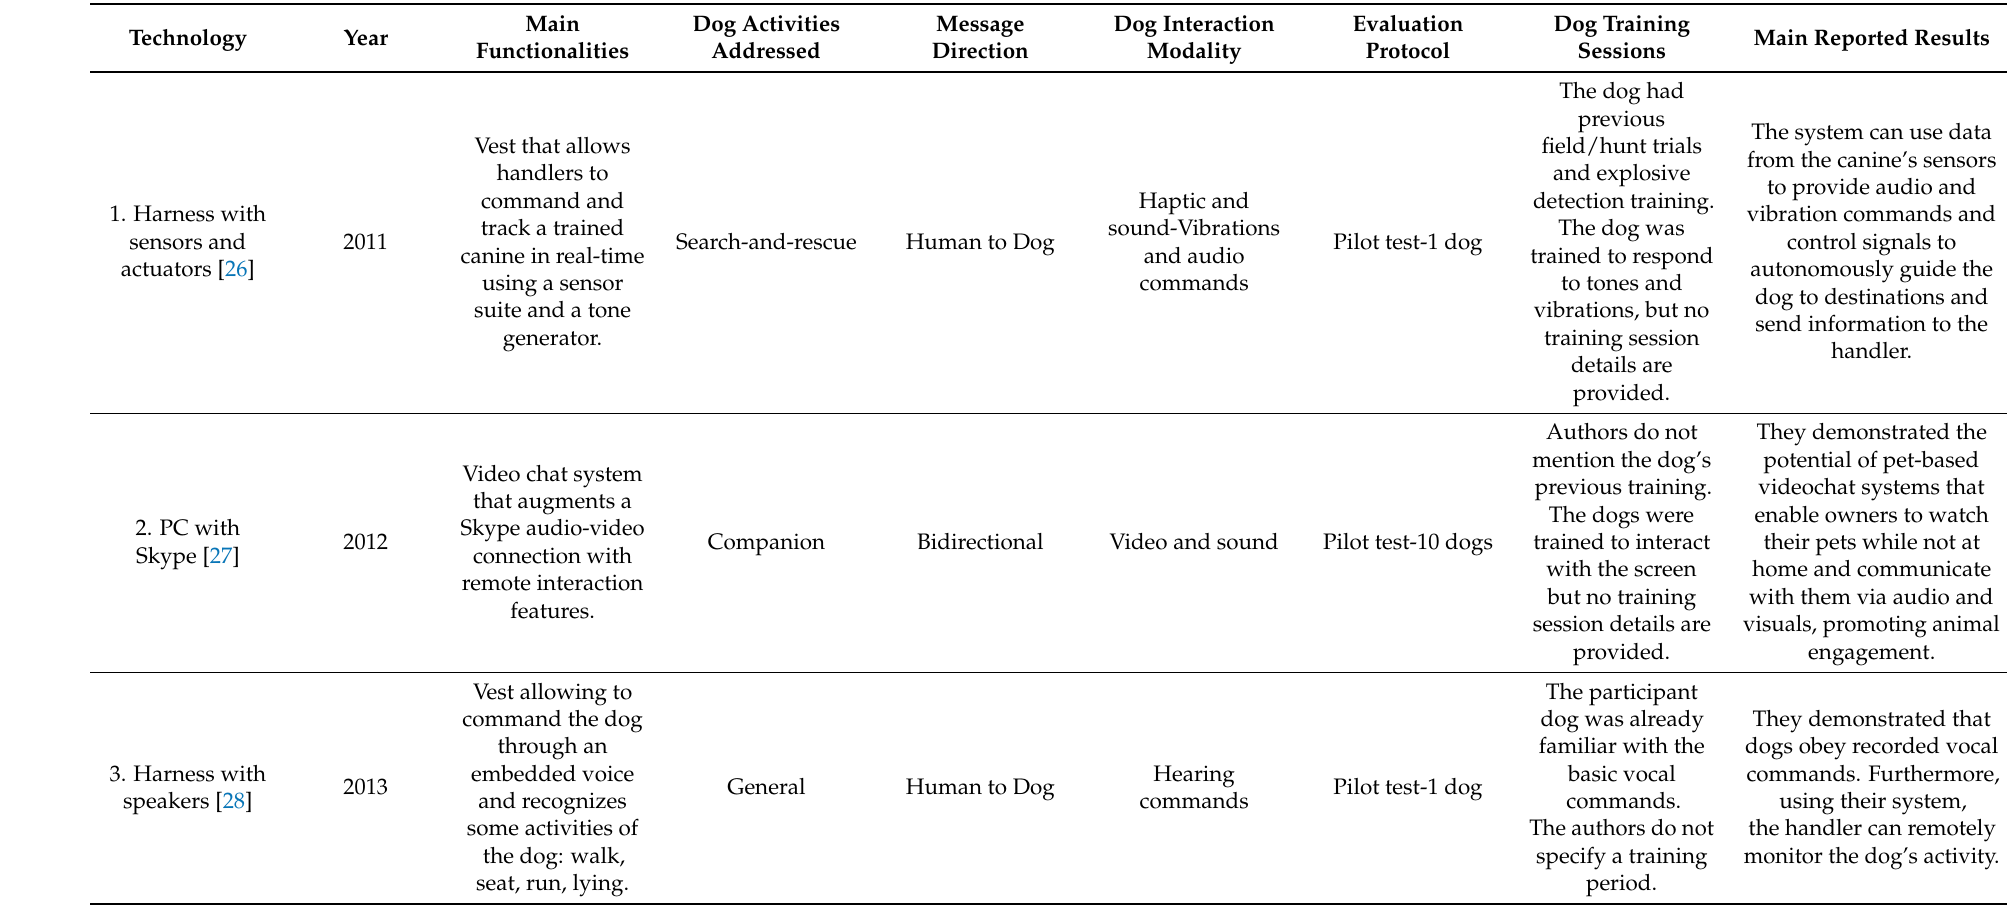
Table 2. Summary of the main characteristics of the reviewed technologies (n =